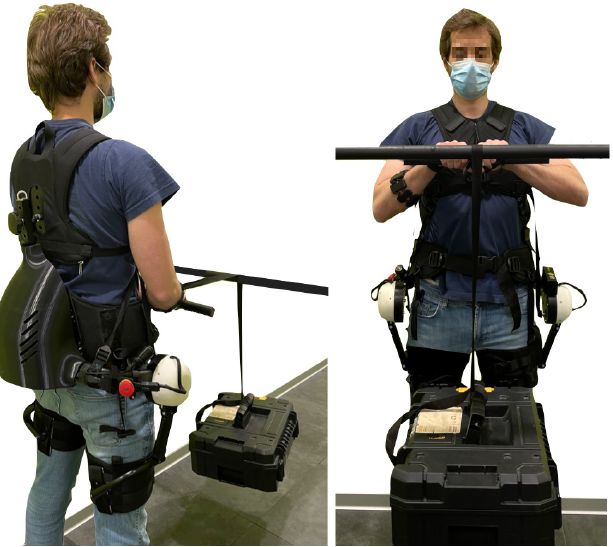
Figure 2. The experimental setup with the pull cable attached on one side to the box and on the other side to a bar, which is pulled by the subject. The figure displays pulling at waist level ( left ) and shoulder level ( right ) in the exo assistance